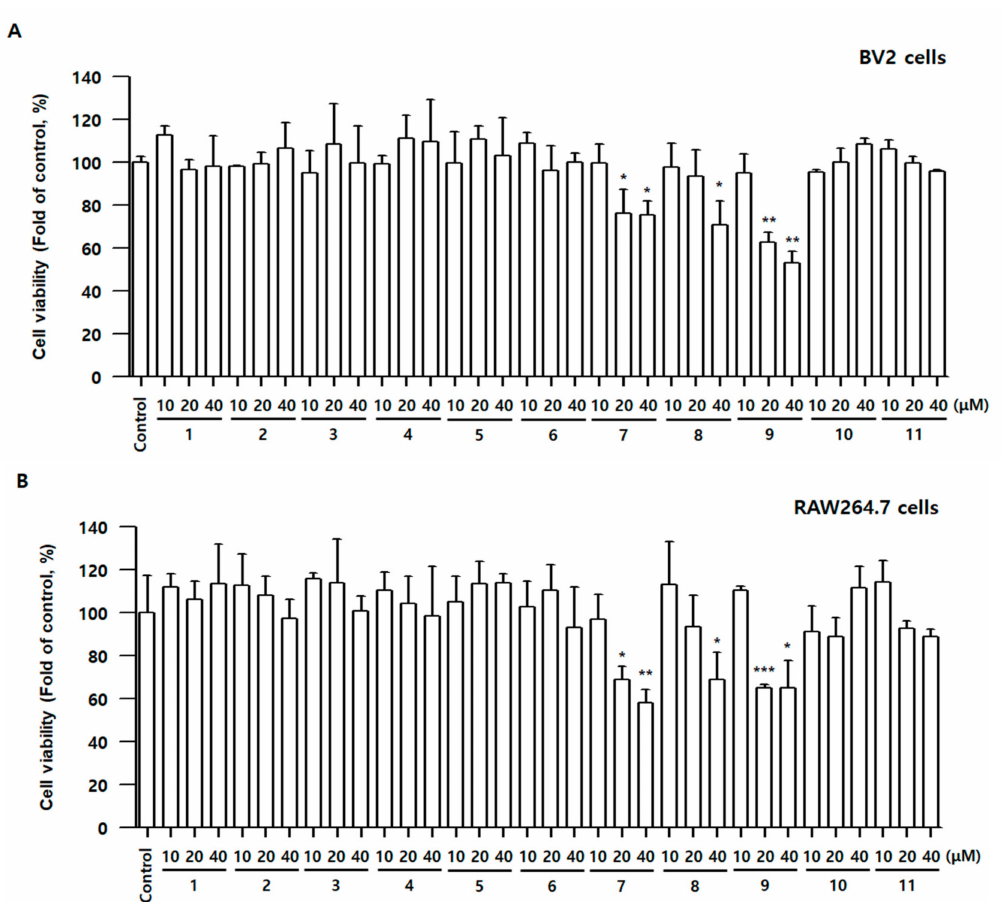
Figure 3. Effects of compounds 1 – 11 on cell viability in BV2 ( A ) and RAW264.7 ( B ) cells. The cells were incubated for 48 h with various concentrations of compounds 1 – 11 . Cell viability was determined using 3-(4,5-dimethylthiazol-2-yl)- 2,5-diphenyltetrazolium bromide assay. Bars represent means ± standard deviation of three independent experiments. * p < 0.05, ** p < 0.01, *** p < 0.001 compared with control